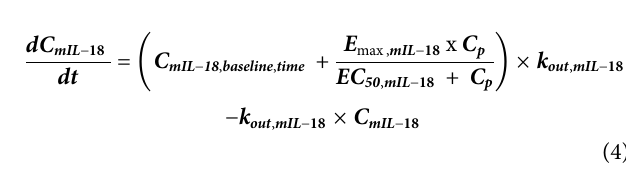
Frontiers in Pharmacology |